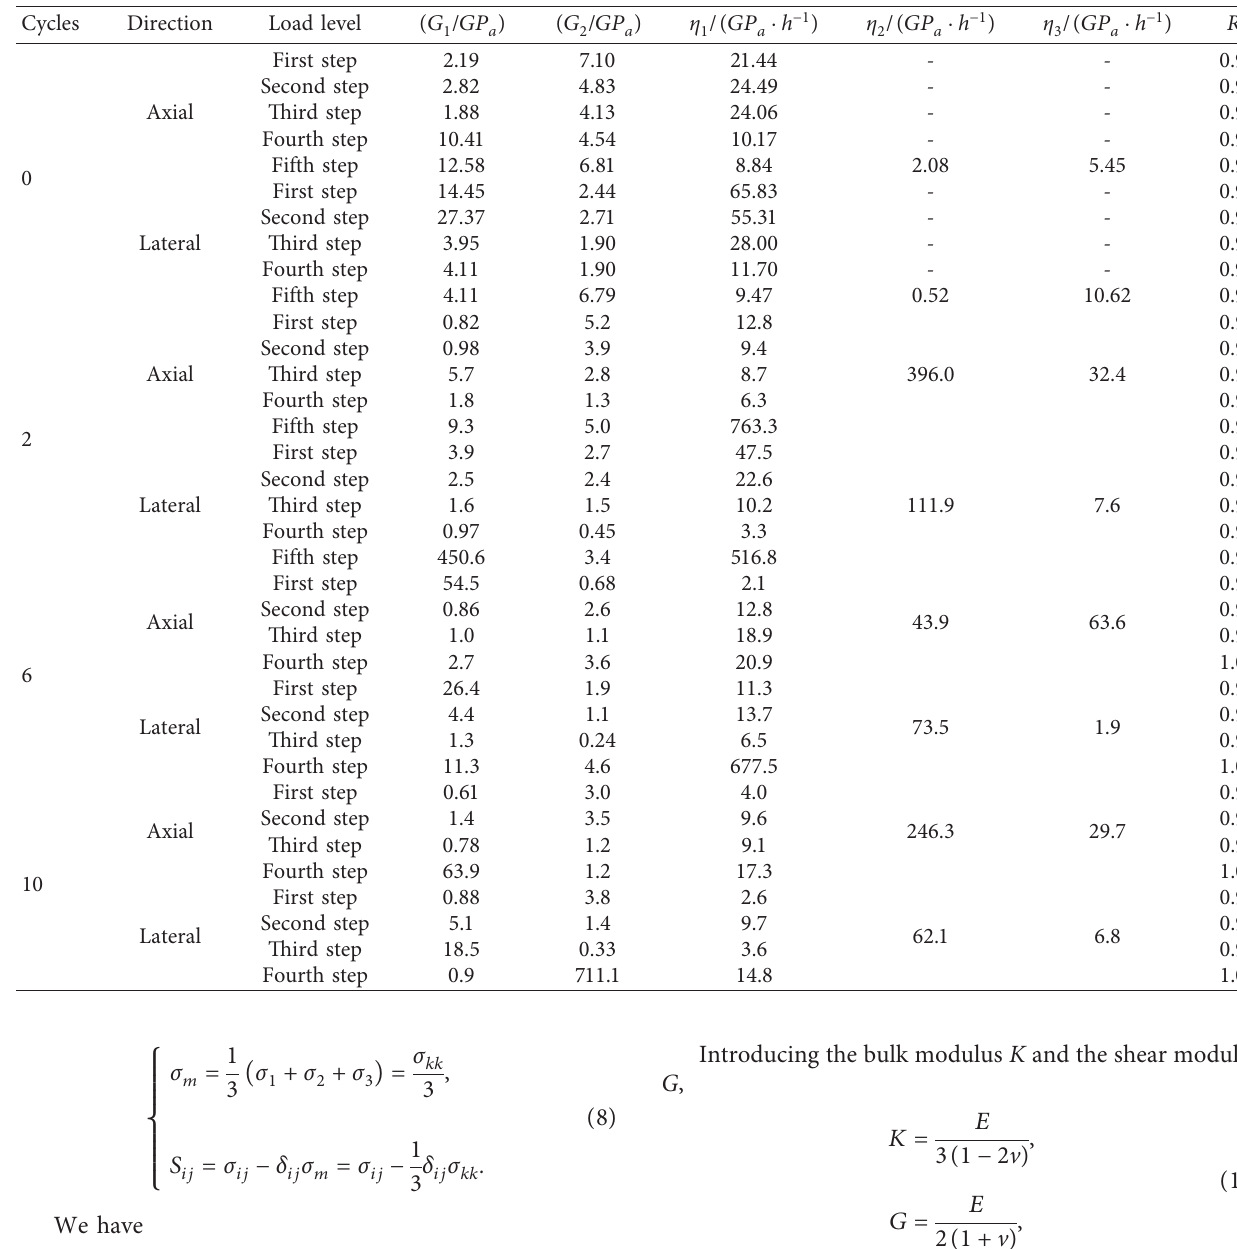
Table 1: Identified parameters for the nonlinear creep constitutive